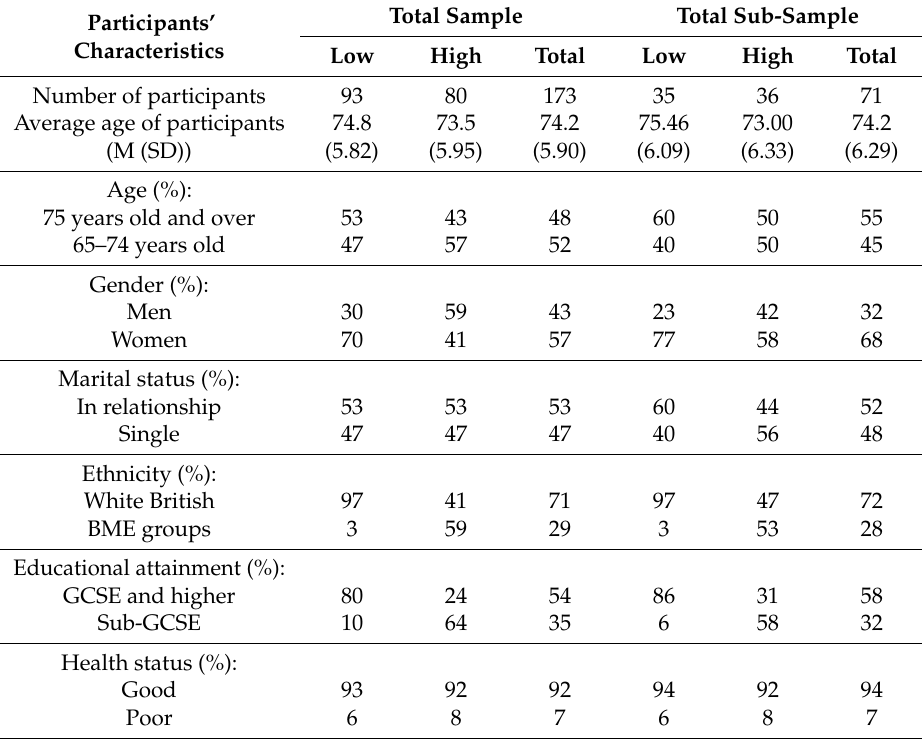
Table 4. Sample characteristics in low- and high-deprivation areas and in